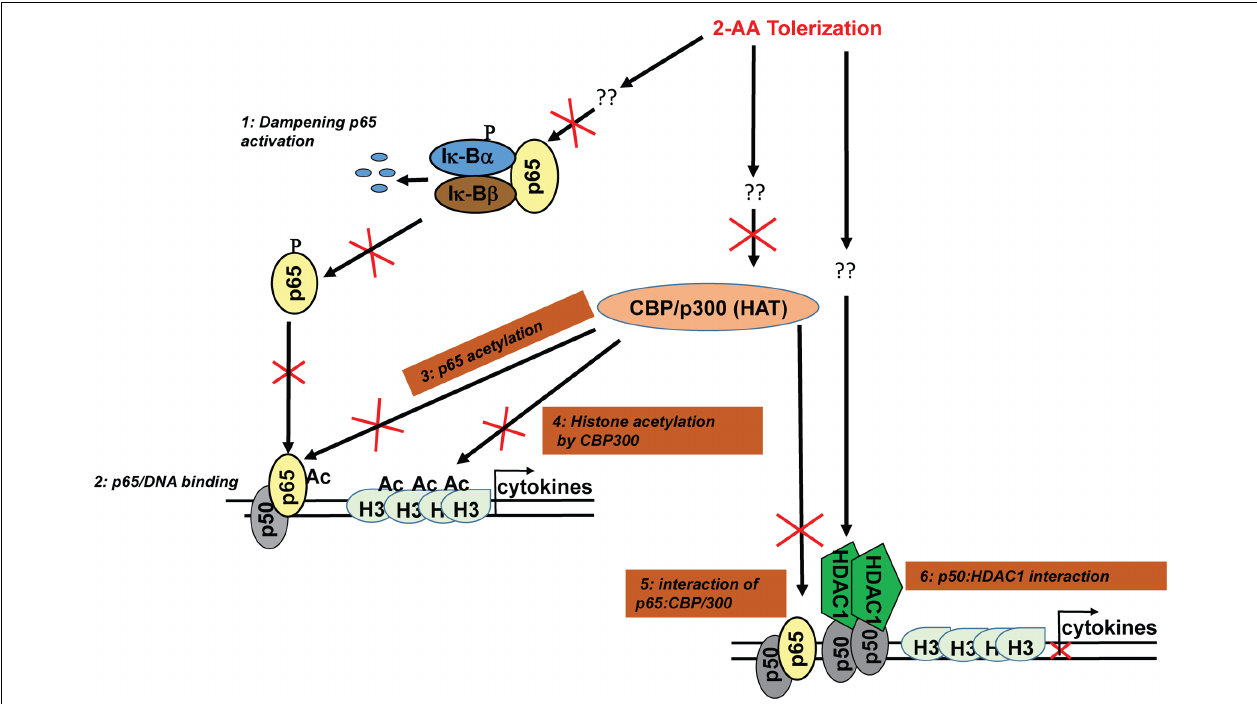
FIGURE 1 | 2-AA-mediated immunomodulation. Our studies have shown that 2-AA tolerization dampens the activation of NF- κ B pathway (1) (Bandyopadhaya et al., 2012). The DNA binding activity of NF- κ B p65 (2) (Bandyopadhaya et al., 2012) is impaired due to reduced acetylation level of p65 in 2-AA-tolerized cells (3 this study). 2-AA tolerization reduces histone acetylation (H3) via downregulation of CBP/p300 HAT activity and expression (4 this study) and the protein–protein interaction between p65 and CBP/p300 (5 this study). The upregulation of HDAC1 initiates HDAC1–p50 interaction and p50 homodimer–HDAC1 complexes are recruited at targeted sites (6 this study). Consequently, HDAC1 acts to deacetylate H3 and dampens transcription of